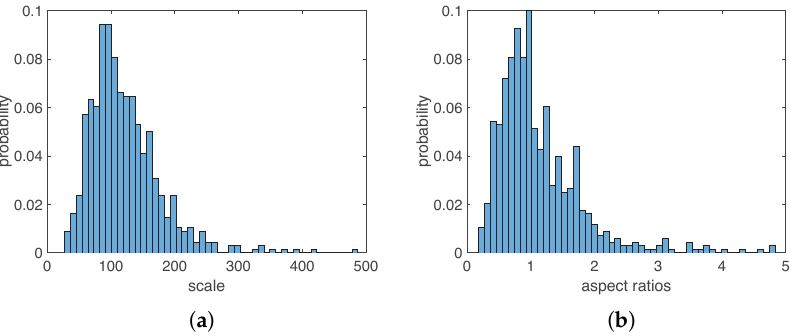
Figure 3. The distribution of airport regions on training set. ( a ) The distribution of scale; ( b ) the distribution of aspect